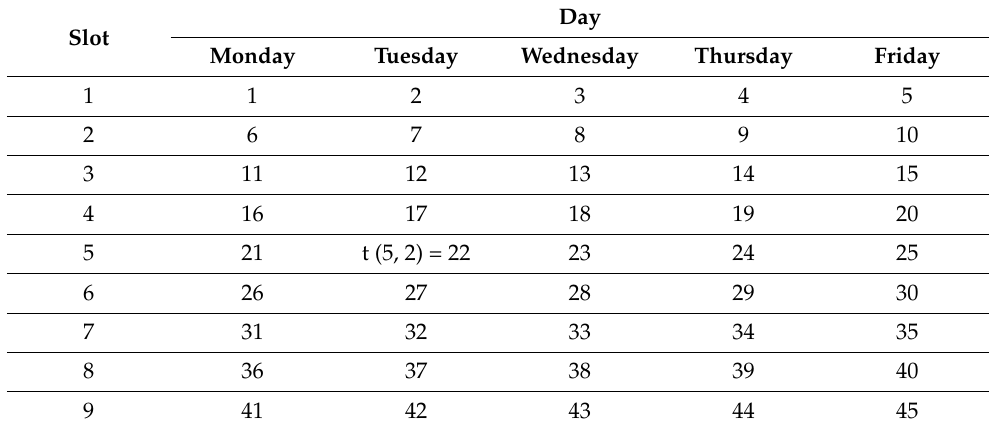
Table 1. Two-dimensional table of schedules assigned to a room with 45 timeslots.